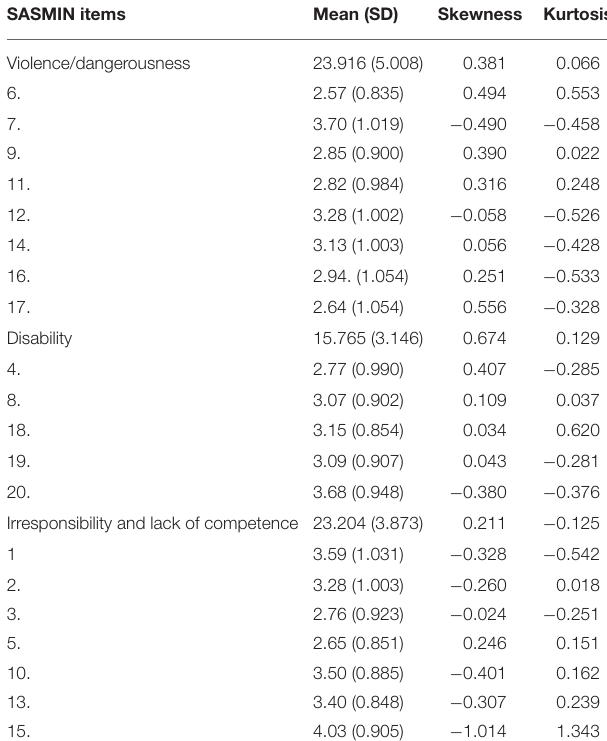
TABLE 5 | Mean (SD) scores and skewness and kurtosis values of the